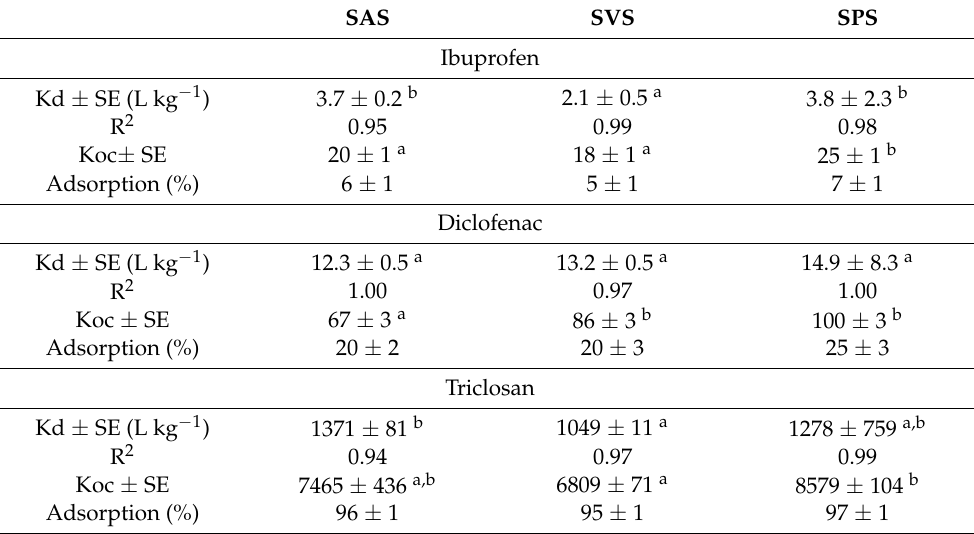
Table 2. Distribution (Kd), determination (R 2 ) coefficients, coefficient normalized by the organic carbon content (Koc) and total amount adsorbed (%) for the adsorption of ibuprofen, diclofenac and triclosan in SAS, SVS and SPS